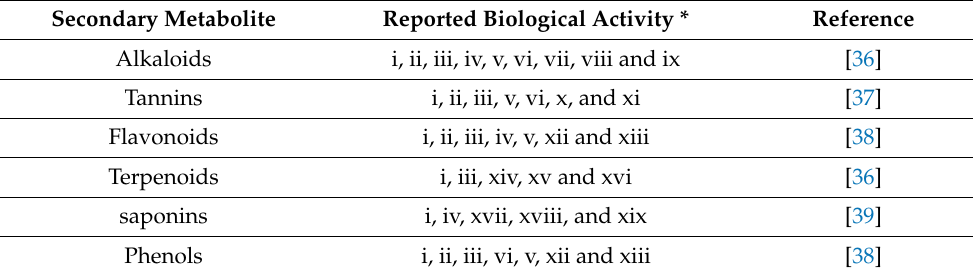
Table 7. Biological activities of various secondary metabolites: